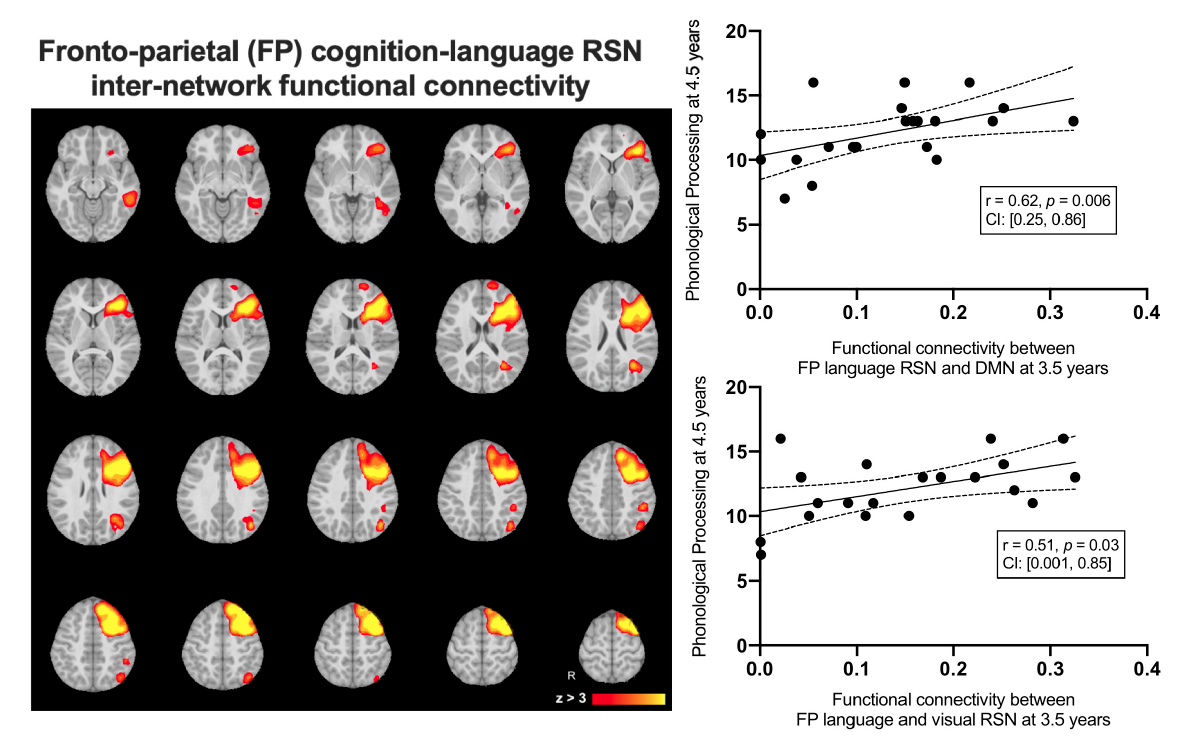
FIGURE4 The group average left-lateralized fronto-parietal resting state network (left) and the linear relationships between inter-network functional connectivity at 3.5 years predicting Phonological Processing scores at 4.5 years of age.